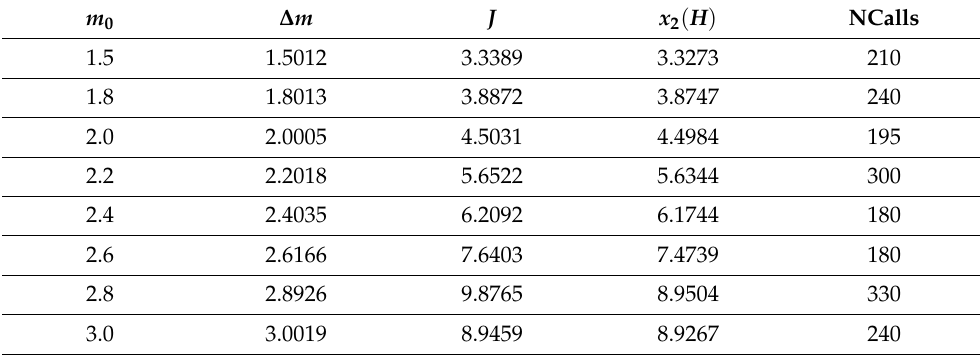
Table 5. Results produced by the standalone couple SENSOR – Predictor